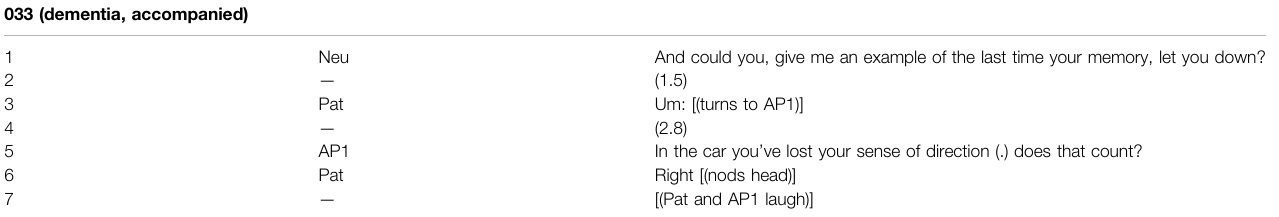
TABLE 2 | Head-turning sign ( “ Last time memory let you down ”